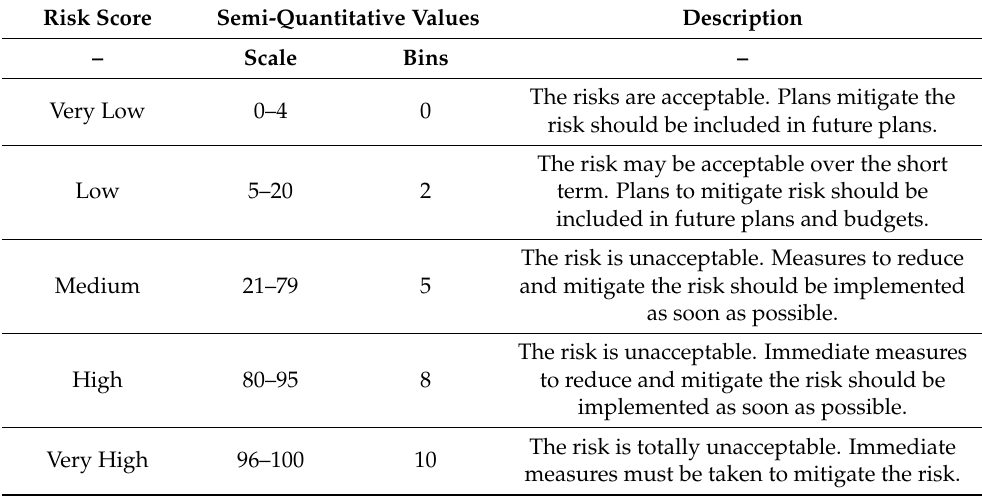
Table 10. Risk acceptability criteria (Qualitative